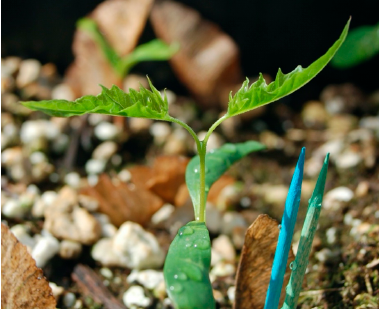
Figure 3. A droplet of 150 μ M oryzalin semi ‐ solidified using 0.2% agar was applied to the meristem of a Norway maple seedling. 2.3. Assessing Ploidy Level Flow cytometry analysis of extracted nuclei stained with DAPI (4 ′ ,6 ‐ diamidino ‐ 2 ‐ phenylindole) was carried out according to Contreras and Shearer [10] with the modification that only one sample was used for parent and seedlings.